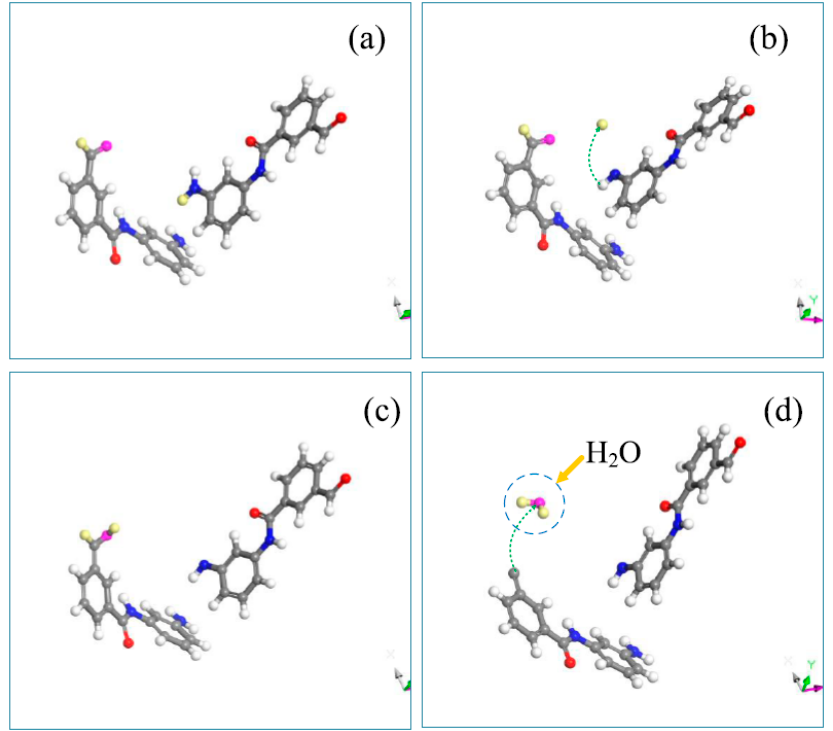
Figure 10. Generation path snapshots of H 2 O micromolecule under decomposition at 2000 K: ( a ) 30.1 ps, ( b ) 48.1 ps, ( c ) 48.4 ps, and ( d ) 52.8 ps.